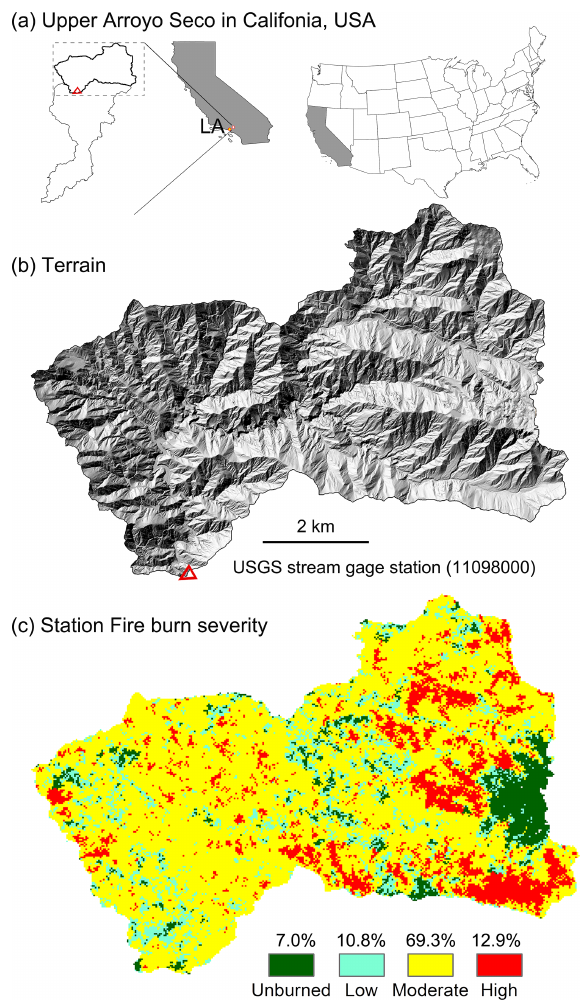
Figure 1. Modified from Fig. 1 in Liu et al. (2021) (a) The location of the upper Arroyo Seco watershed within California. The red tri- angle indicates the location of the USGS stream gage (11098000); (b) Shaded relief showing the study watershed with the USGS stream gage (red triangle; 34 ◦ 13 (cid:48) 20 (cid:48)(cid:48) , − 118 ◦ 10 (cid:48) 36 (cid:48)(cid:48) ); (c) Soil burn severity for the 2009 Station fire. Burn severity percentages are for planform area within each